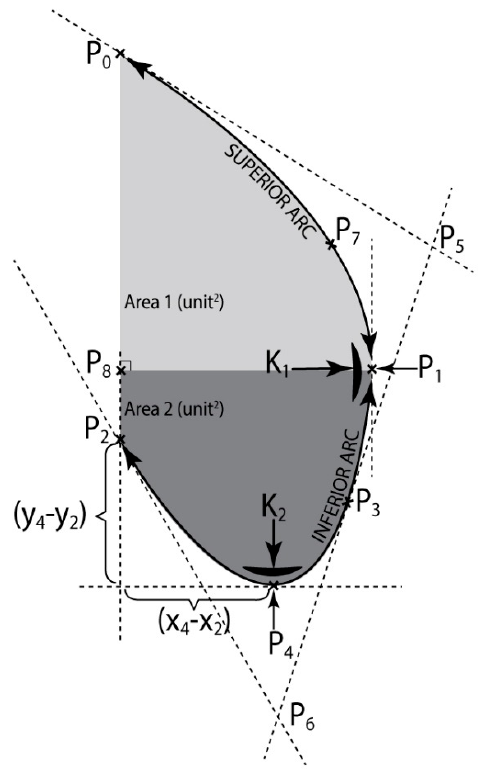
Figure 3. Mathematical modeling of thoracic-abdominal profile.